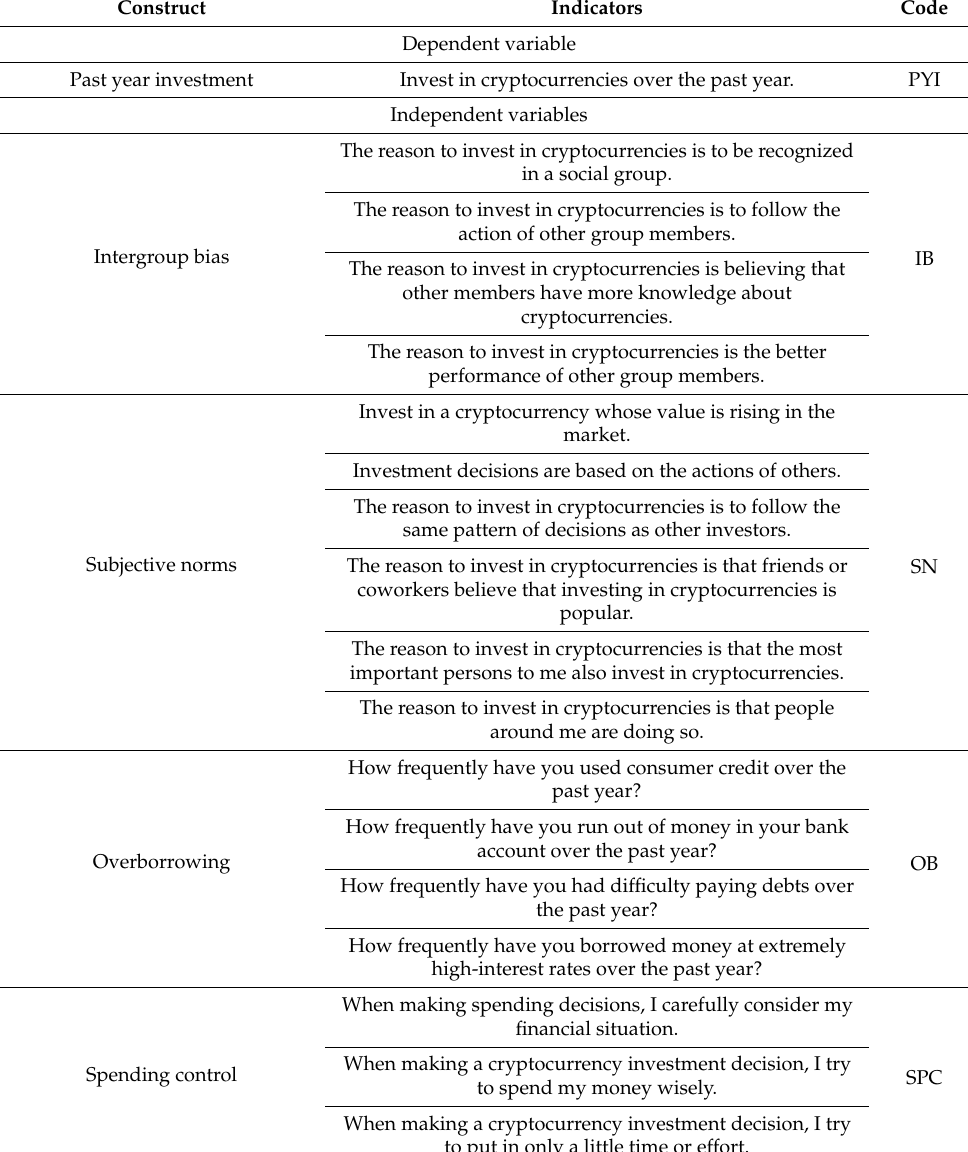
Table 2. Definition of variables and